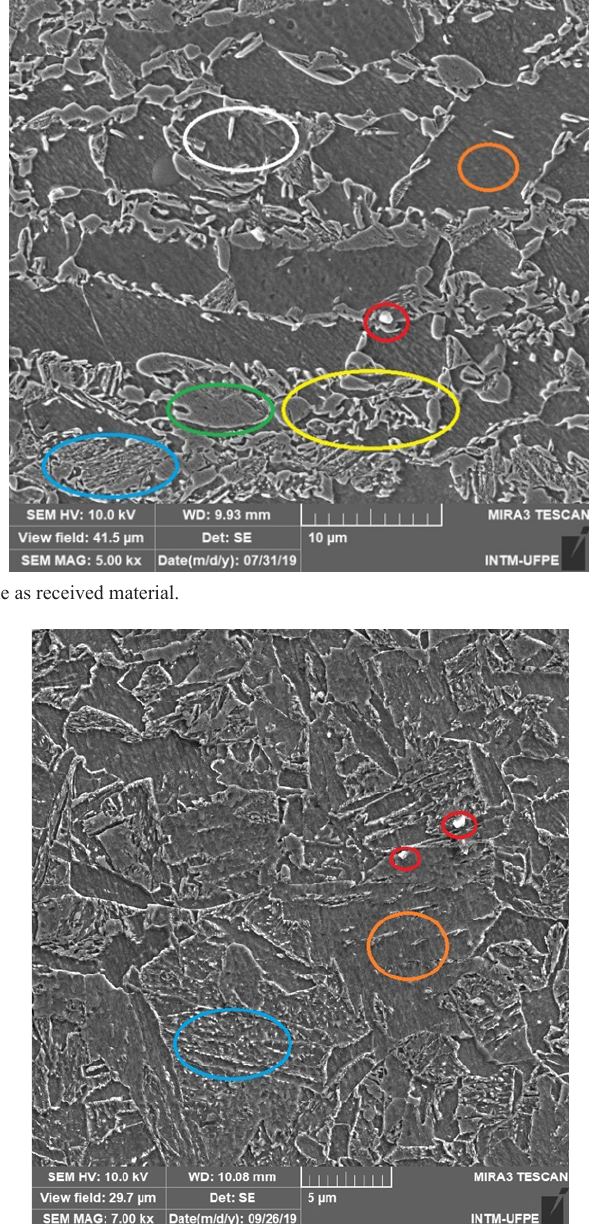
Figure 4. Microstructure of the material produced by the 380-15